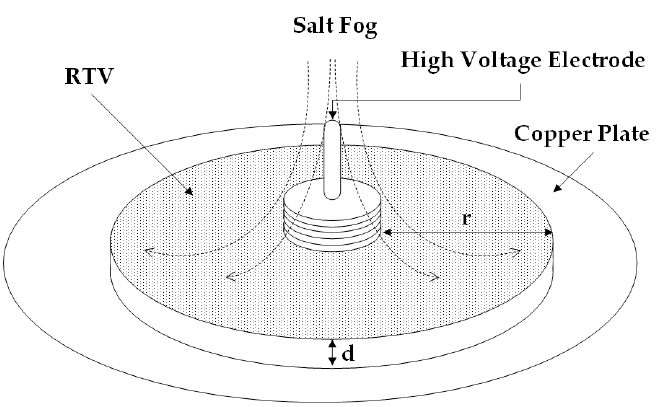
Figure 2. Test circuit of surface discharge.